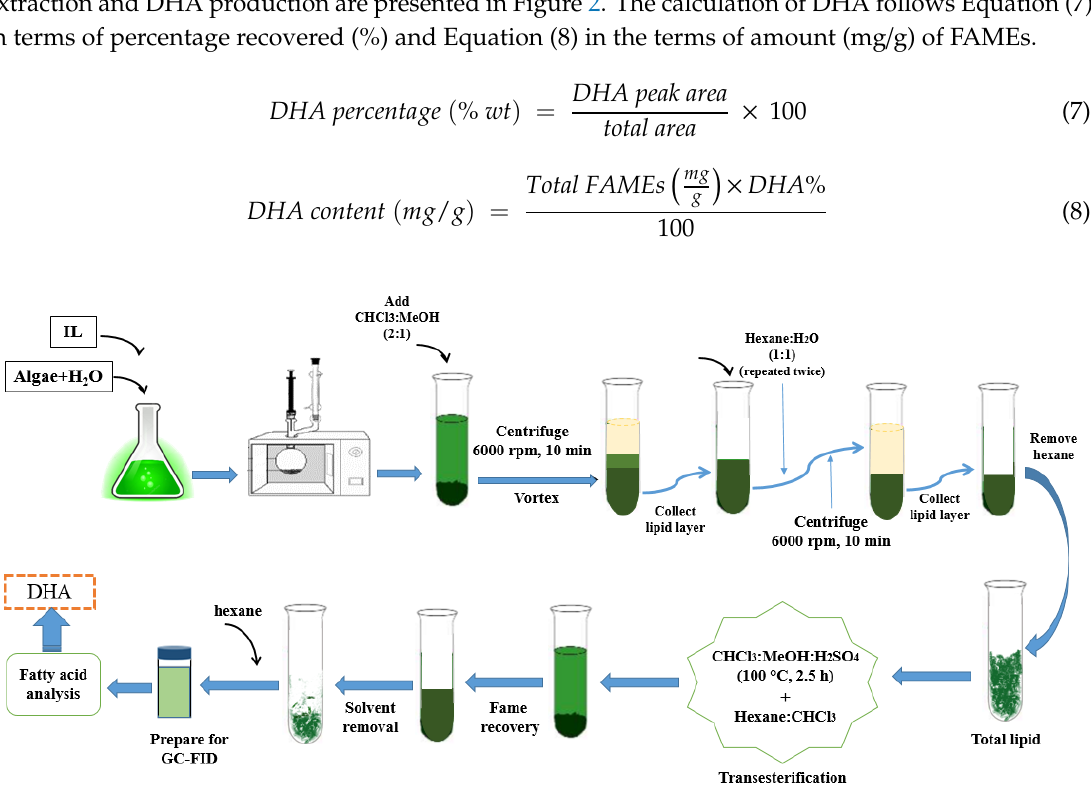
Figure 2. Schematic of experimental setup of lipid and DHA extraction from microalgae biomass.